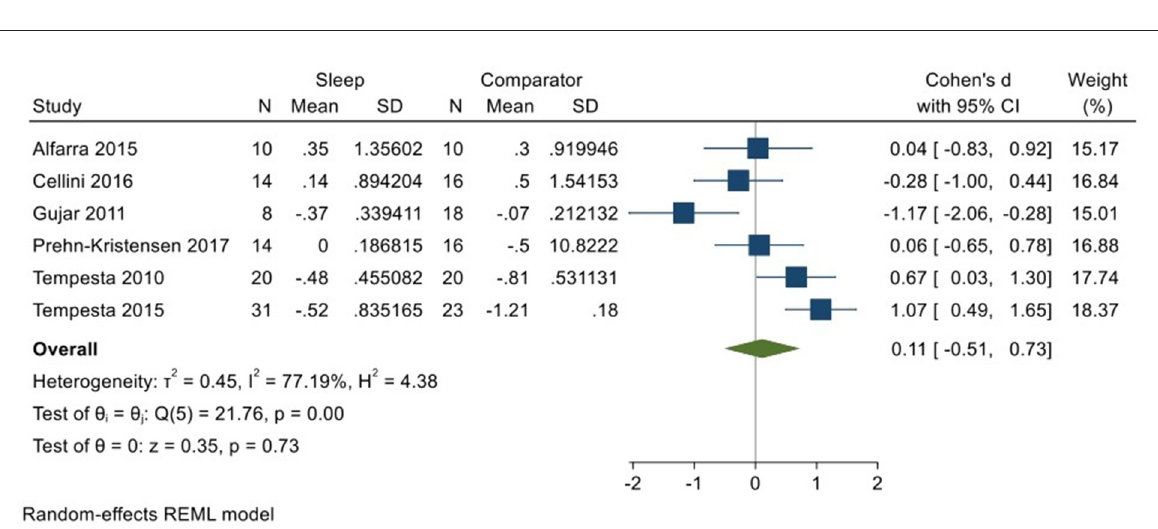
FIGURE8 Meta-analysis V: Outcomes for self-reported valence ratings in response to positive stimuli – changes across a period of sleep compared to across a period of waking ( K = 6, N =